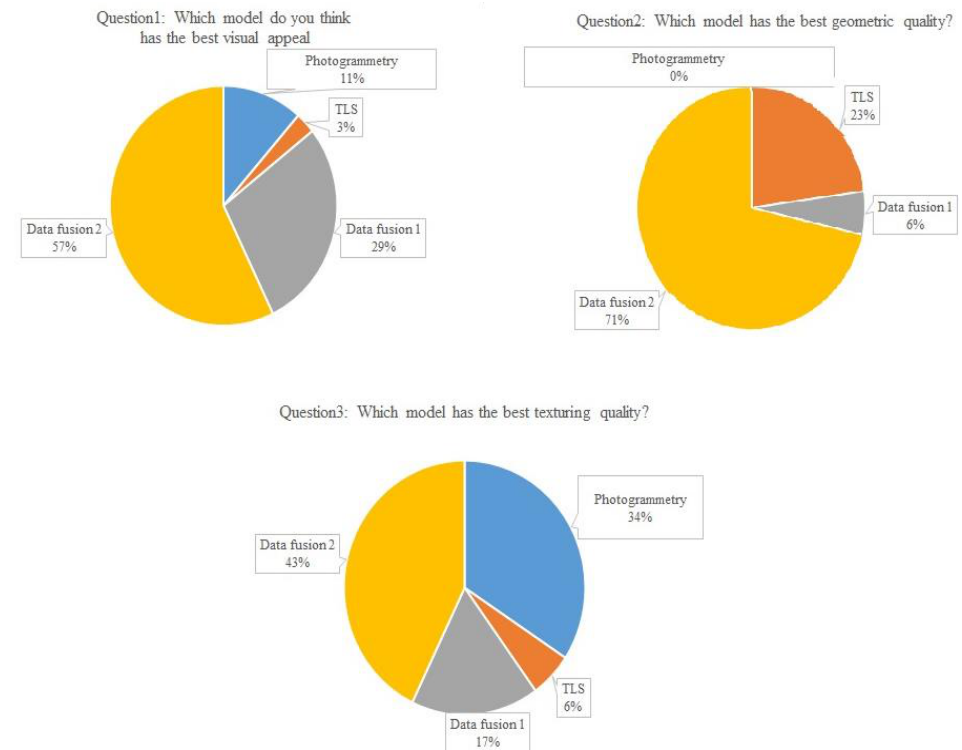
Figure 19. Results of the expert evaluation on visual quality for the modelling methods: photogram- metry (blue), TLS (orange), data fusion 1 (gray), data fusion 2 (yellow).